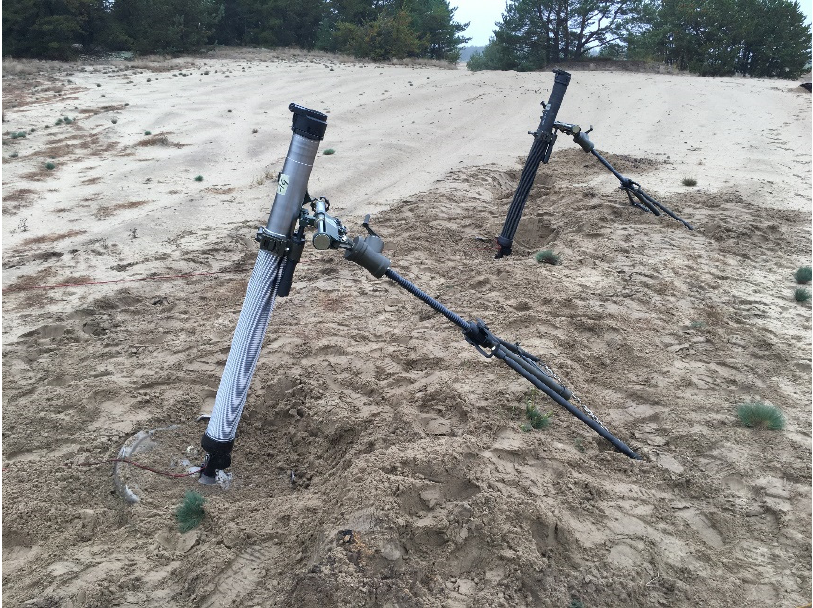
Figure 12. The mortars on the firing position.